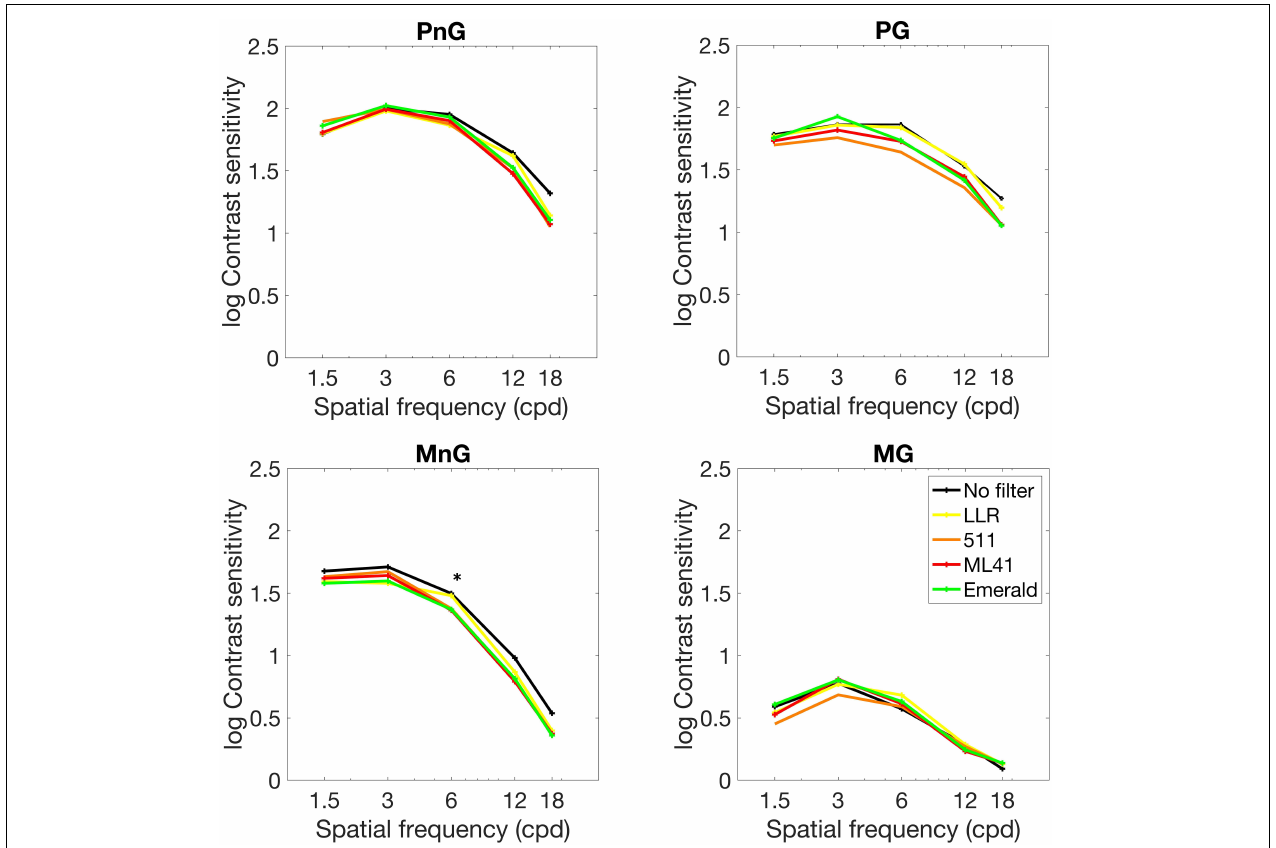
FIGURE 3 | Average photopic and mesopic contrast sensitivity contrast sensitivity measured with different filters under no glare and glare conditions. See Figure 2 legend for the abbreviations. The contrast sensitivity at 6 cpd showed a significant difference with different filter conditions in MnG condition (marked with ∗ ). 511, ML41 and emerald filters reduced the contrast sensitivity values compared to no filter